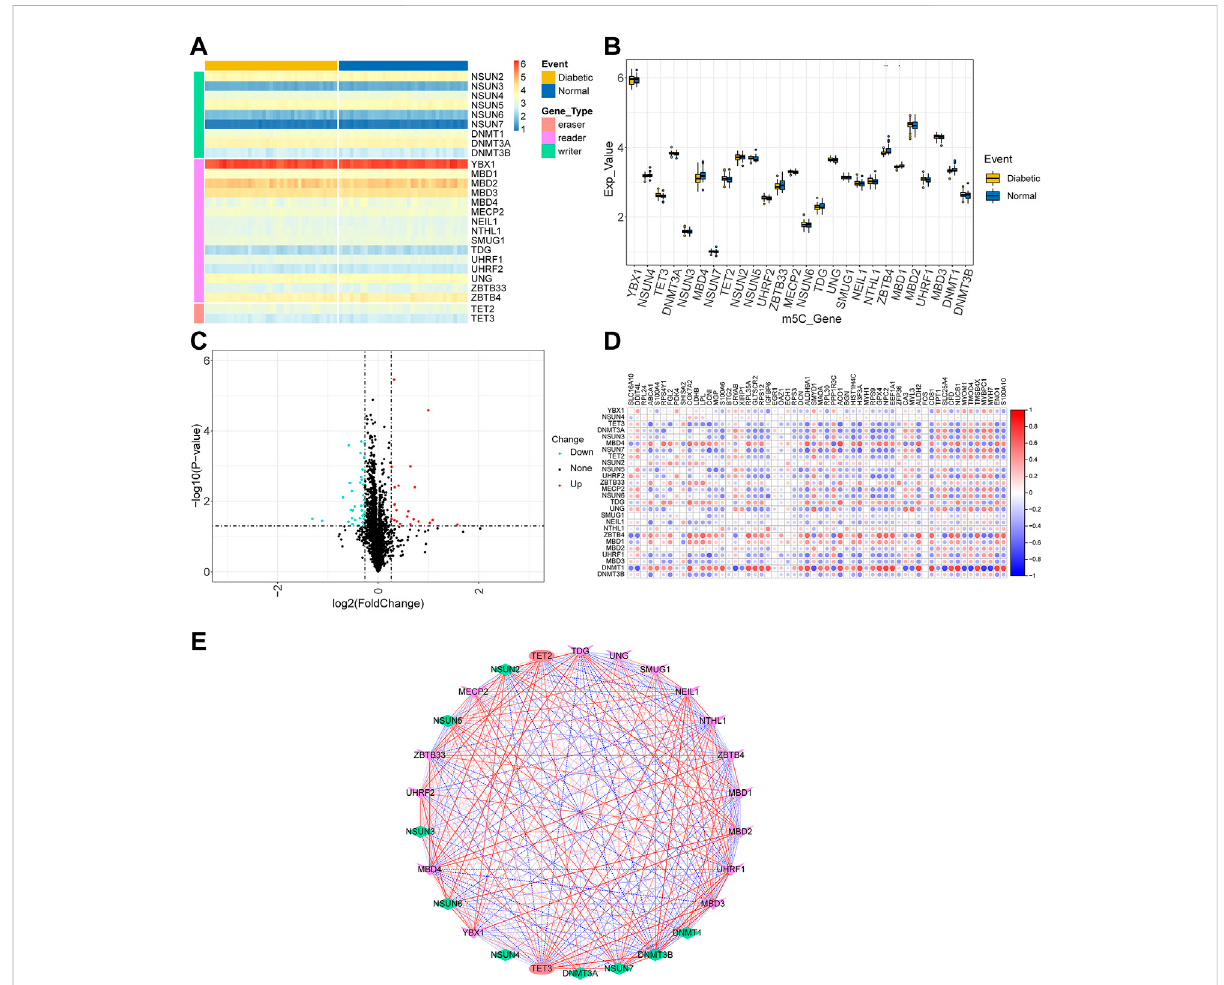
FIGURE 2 Landscape of m5C-related genes. (A) Heatmap of the m5C-related genes. (B) Boxplot of m5C-related genes. Ns indicates not signi fi cant ( p > 0.05), and * p < 0.05, ** p < 0.01, *** p < 0.001, **** p < 0.0001 represent signi fi cant p -values. (C) Volcano plot of T2D-related differentially expressed genes. (D) Correlations among m5C-related genes and T2D-related differentially expressed genes. (E) Network diagram of the correlation interaction between m5C-related